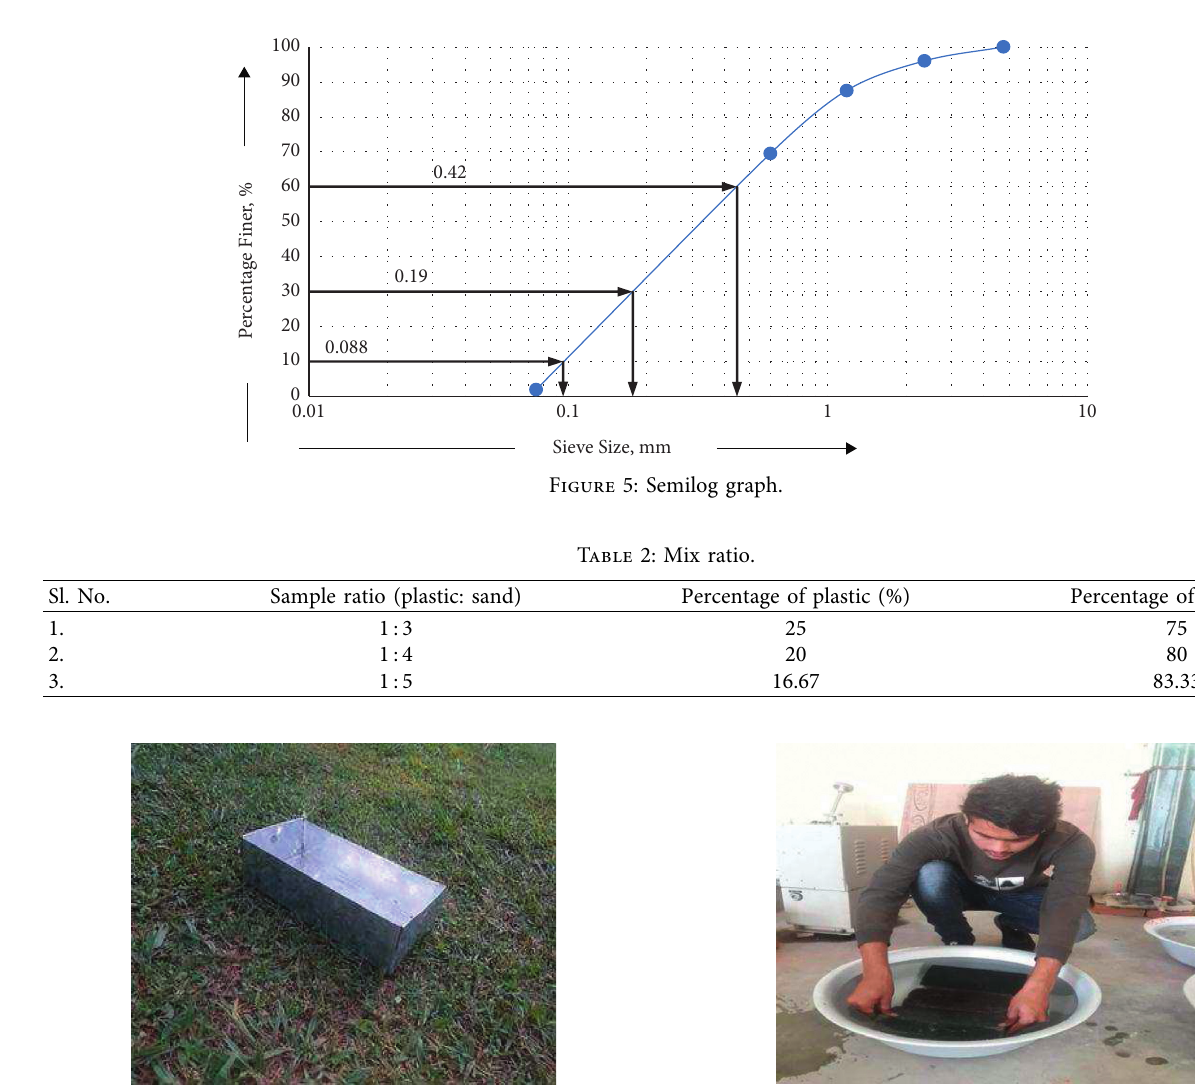
Figure 6: Mould prepared for the casting of bricks. Figure 7: Water absorption